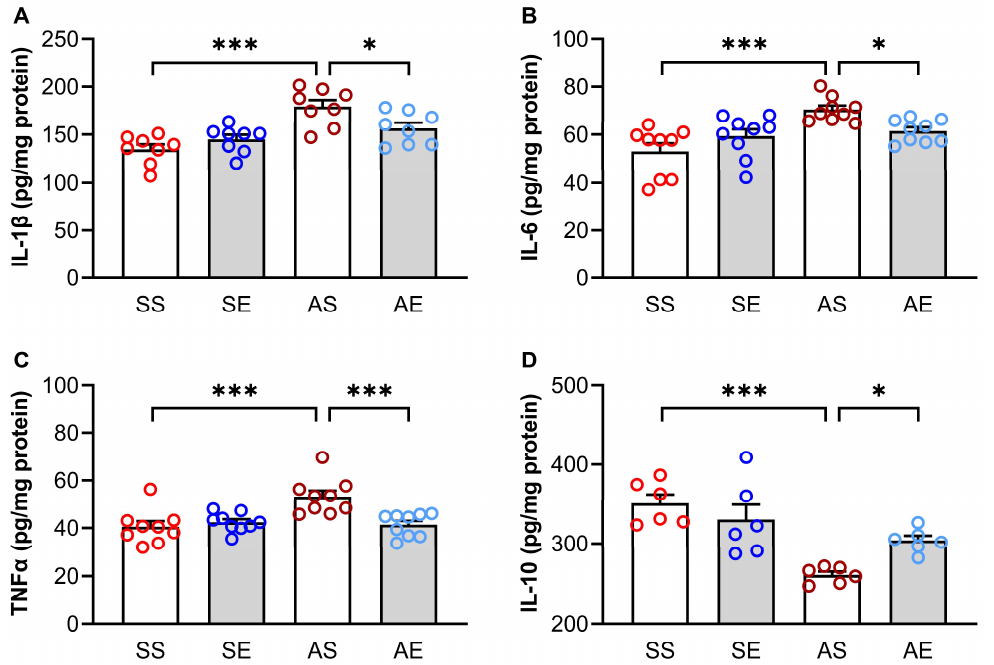
Figure 3. Treadmill exercise reversed AIE-induced inflammation in the hippocampus of young adult rats. ( A ) The protein level of IL-1 β in the hippocampus of rats in each group. The level of IL-1 β was increased in the AS rats compared to the SS rats. The increased level of IL-1 β was prevented by treadmill exercise intervention (* p < 0.05, *** p < 0.001, n = 8). ( B ) The protein level of IL-6 in the hippocampus of rats in each group. The level of IL-6 was increased in the AS rats compared to the SS rats. The increased level of IL-6 was prevented by treadmill exercise intervention (* p < 0.05, *** p < 0.001, n = 9). ( C ) The protein level of TNF- α in the hippocampus of rats in each group. The level of TNF- α was increased in the AS rats compared to the SS rats. The increased level of TNF- α was prevented by treadmill exercise intervention (*** p < 0.001, n = 9). ( D ) The protein level of IL-10 in the hippocampus of rats in each group. The level of IL-10 was decreased in the AS rats compared to the SS rats. The decreased level of IL-10 was prevented by treadmill exercise intervention (* p < 0.05, *** p < 0.001, n =